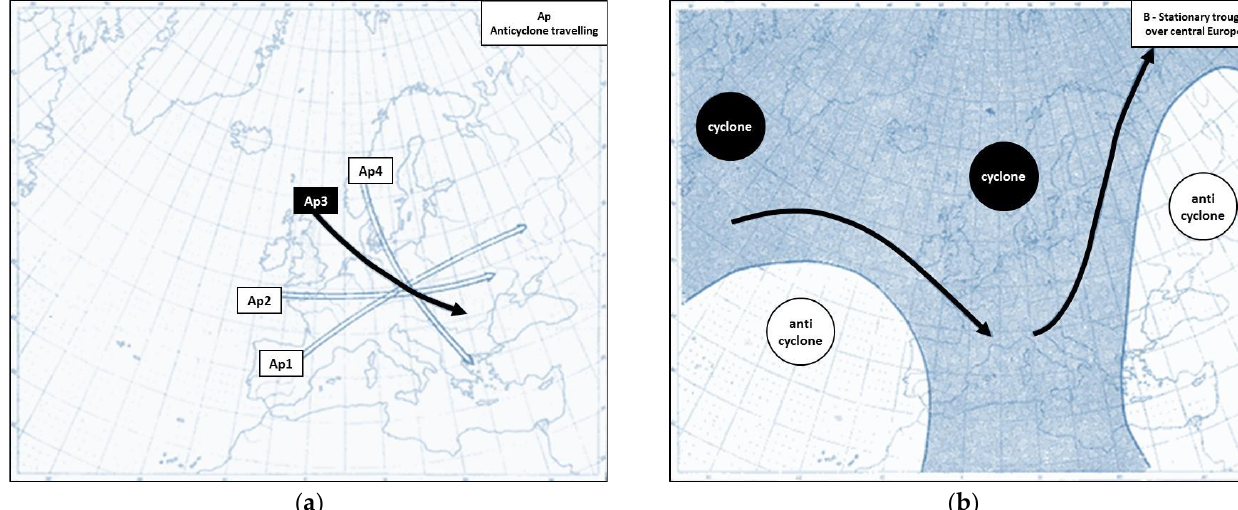
Figure 7. “ Ap 3 “ ( a ) and “B“ ( b ) synoptic events. Figure 7. “Ap 3 ” ( a ) and “B” ( b ) synoptic